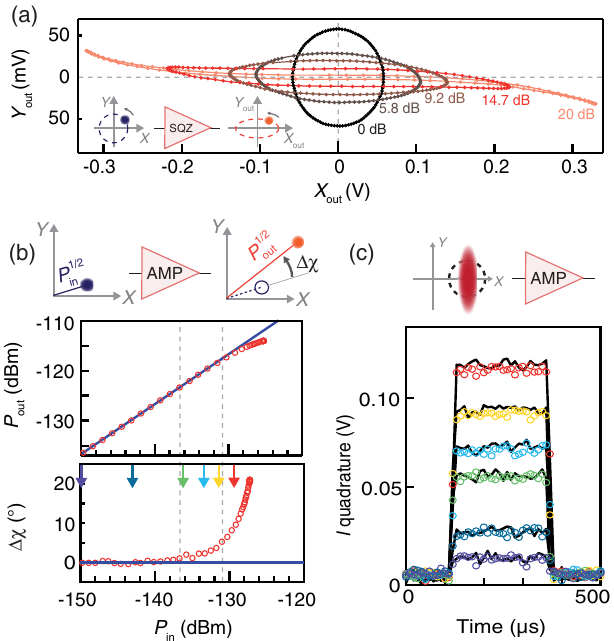
FIG. 4. Limitations induced by JPA saturation. (a) Output quadratures X and Y measured for weak coherent signals out out sent to the SQZ with input phases ϕ spanning the whole interval S indicated by the between 0 and 2 π for 4 different gains G − 2 S arrows in Fig. 3(d) and set using different pump powers (black curve corresponds to SQZ pump off). Note that these data are obtained in a separate calibration run in which the ESR cavity is removed [35]. (b) Measured output power and phase of a signal at ω 0 as a function of its input power P in after amplification by the AMP device, in the same conditions as in (a) but with the JPA operated in the nondegenerate mode by detuning the pump by 300 kHz from 2 ω 0 . The output power depends linearly on P as in < − 131 dBm (blue lines is a linear fit), while the long as P in < − 137 dBm. (c) Time phase shift is zero (blue line) only for P in trace of the I quadrature of a weak microwave pulse at ω 0 sent via the κ port of the ESR cavity, measured with SQZ off (open A FIG. 5. Squeezing-enhanced spin-echo detection. (a) Energy of circles) and SQZ on (black traces) for different input powers the 20 levels of bismuth donors in silicon as a function of B 0 (gray indicated by the arrows in (b). The traces have been averaged lines). The transition between the levels indicated in green is used 4000 times. Above − 136 dBm, deviations appear between the in the experiment. (b) Hahn-echo-detected magnetic field sweep, SQZ on and SQZ off curves due to AMP saturation. showing the bismuth donor resonance line. Blue arrow indicates the field chosen in the rest of the experiment, blue Lorentzian curve indicates the fraction of spins that are within the cavity resonance. (c) Echo signals observed with SQZ off (blue) and on (red) for a single shot (lines) and averaged over 2500 traces (symbols) confirm the signal intensity is identical. SQZ was switched on only during a short Δ t ¼ 200 - μ s window around the echo emission time (dashed rectangle in the pulse sequence). The excitation pulse angle is chosen to be ≈ π = 3 in order to avoid saturation effects (see main text). (d) Histograms of the noise around the average signals of (c) measured with 2500 single-shot traces acquired on a 70 - μ s time window centered on the echo, with SQZ off (blue) and on (red) (see Supplemental Material [34]), and corresponding Gaussian fits (curves). Standard devia- tions are 0 . 0858 (cid:3) 2 × 10 − 4 V for SQZ off and 0 . 0748 (cid:3) 2 × 10 − 4 V for SQZ on, confirming a reduction in the noise accompanying the spin-echo signal when SQZ is